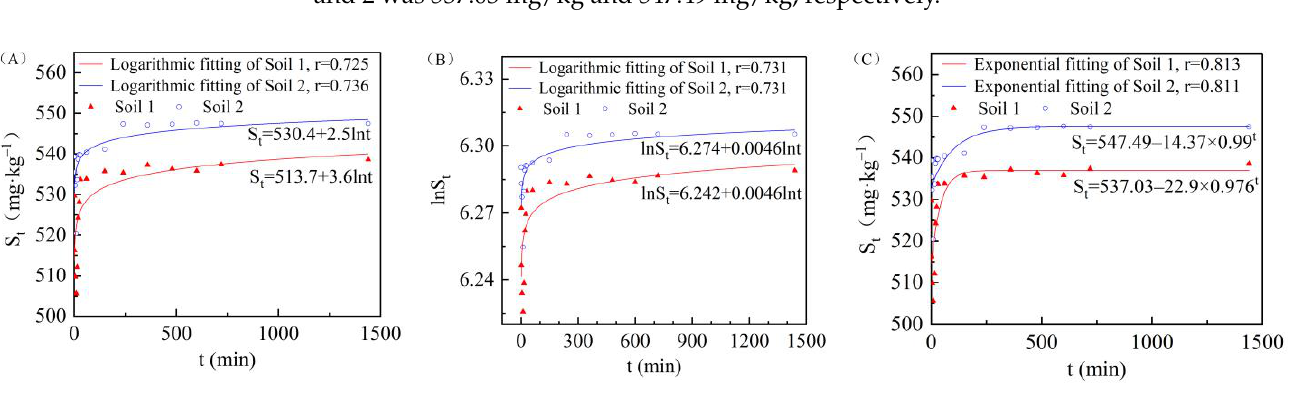
Table 3: when the reaction time t tended to infinity, the saturation adsorption of S m in the two soils increased as the overall pH of the solution increased (the saturation adsorption of soils 1 and 2 was 536.27~540.7 mg/kg and 545.32~547.48 mg/kg, respectively). Under the same pH conditions, the saturation adsorption S m of soil 2 was greater than that of soil 1.